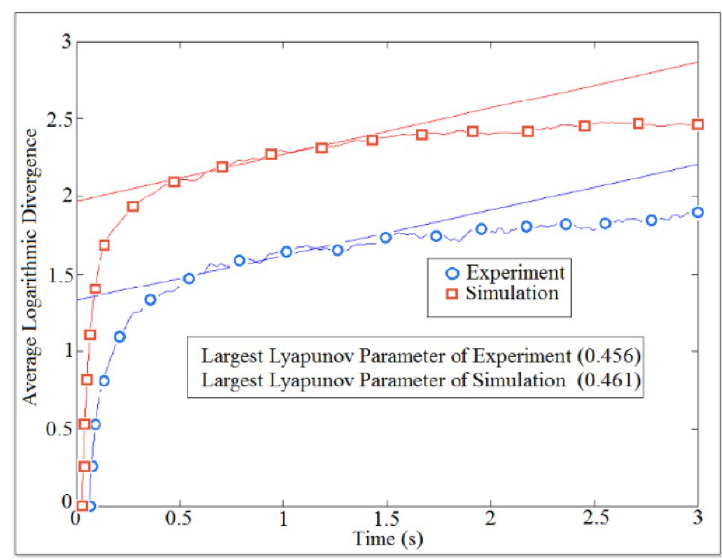
Figure 13. Largest Lyapunov exponent against time for un-stiffened plate.